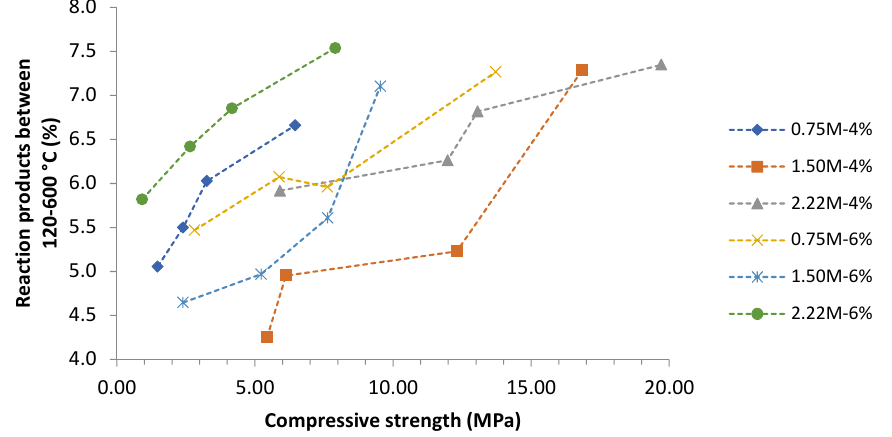
Figure 13. Relationship between reaction product percentages and compressive strength for each paste. For each curve (formulation), each point is the value for each curing time (1, 3, 7 and 28 days).